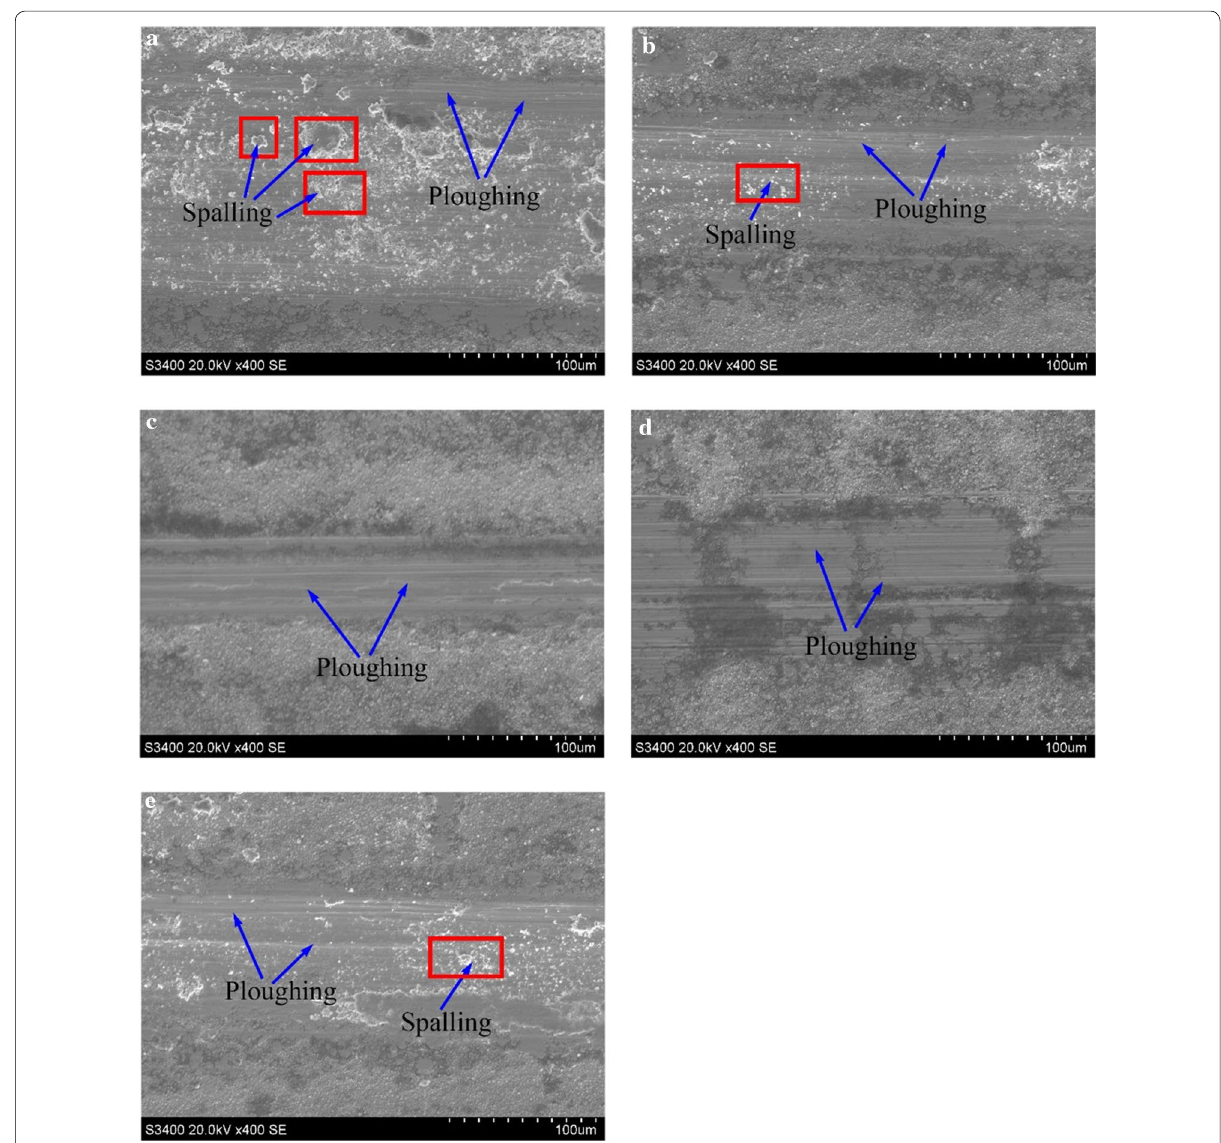
Figure 8 SEM images of the worn surfaces of Ni–Co/SiC coatings obtained at different rotation speeds: a 0, b 400 r/min, c 800 r/min, d 1200 r/min and e 1600